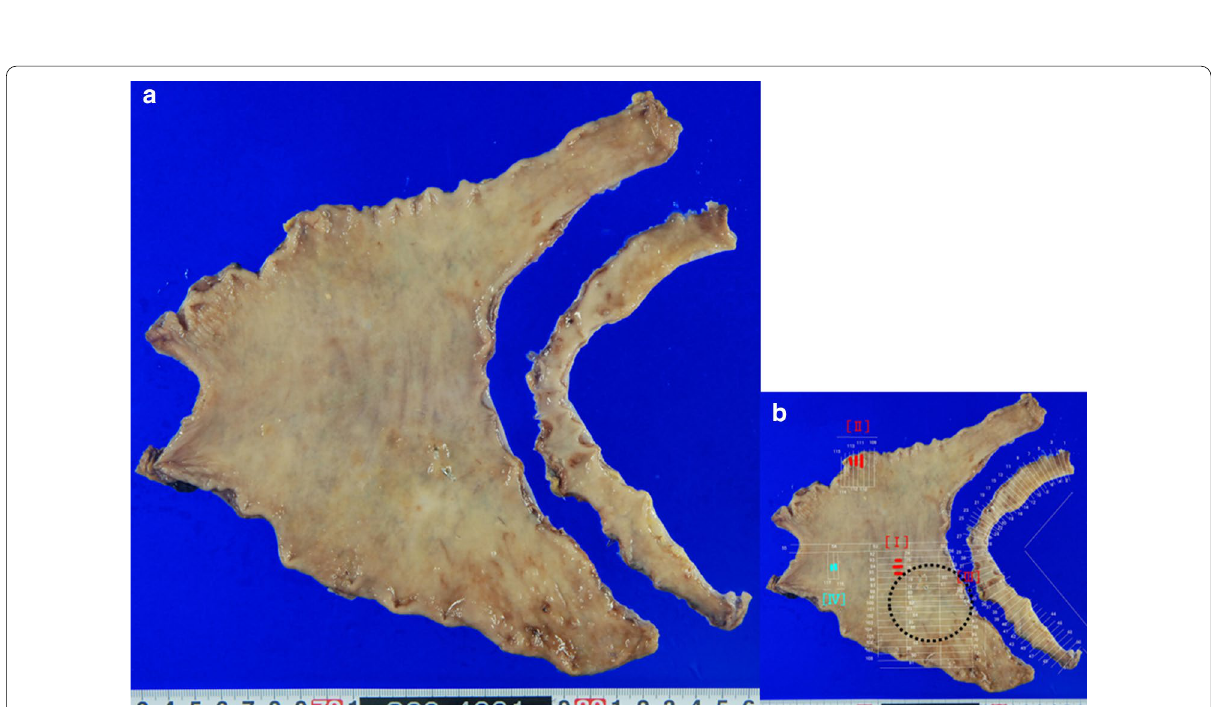
Fig. 4 a Resected stomach. b Mapping of tumors. [I] M, less, Type 0–IIc, 15 (not shown in this figure but in the frozen section); [IV] tubular adenoma, low grade. The black dotted circle indicates the location of the primary gastric cancer, as inferred from pretreatment endoscopic